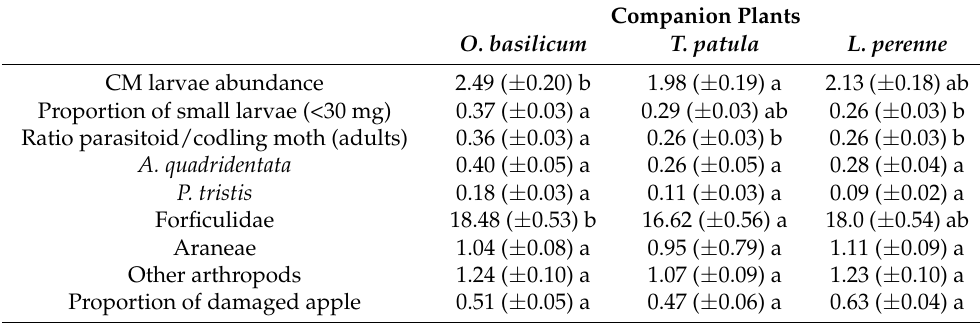
Table 2. Effects of companion plants on codling moth and natural enemy’ abundances and on small larvae and damaged apple proportions. Presented values are means ( ± SE) per tree per week. Letters indicate significant differences between companion plants, according to post-hoc tests ( p value <